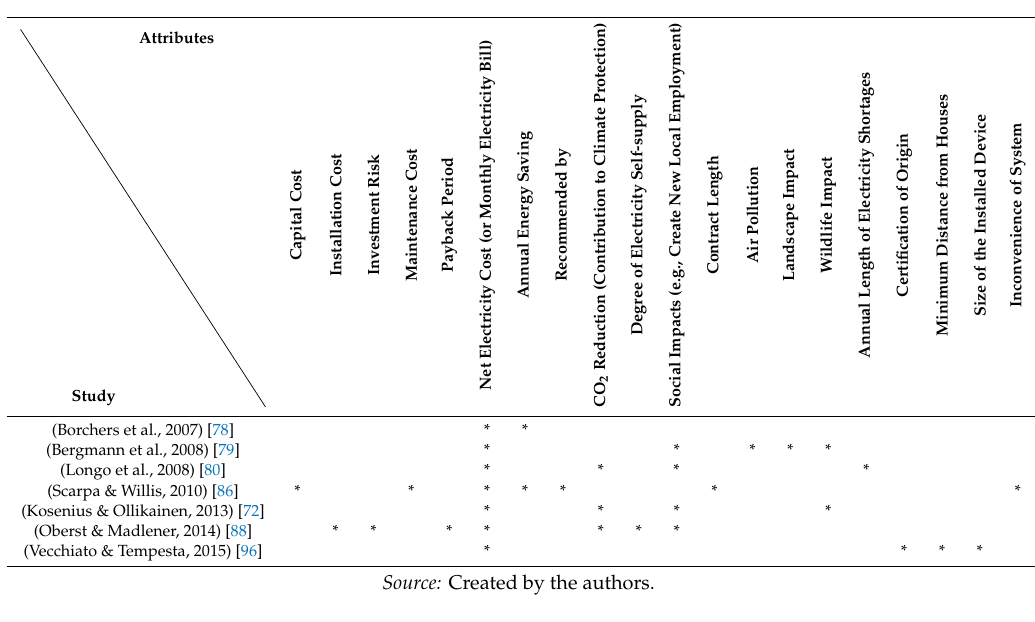
Table 3. Summary of attributes used in empirical studies on WTP for